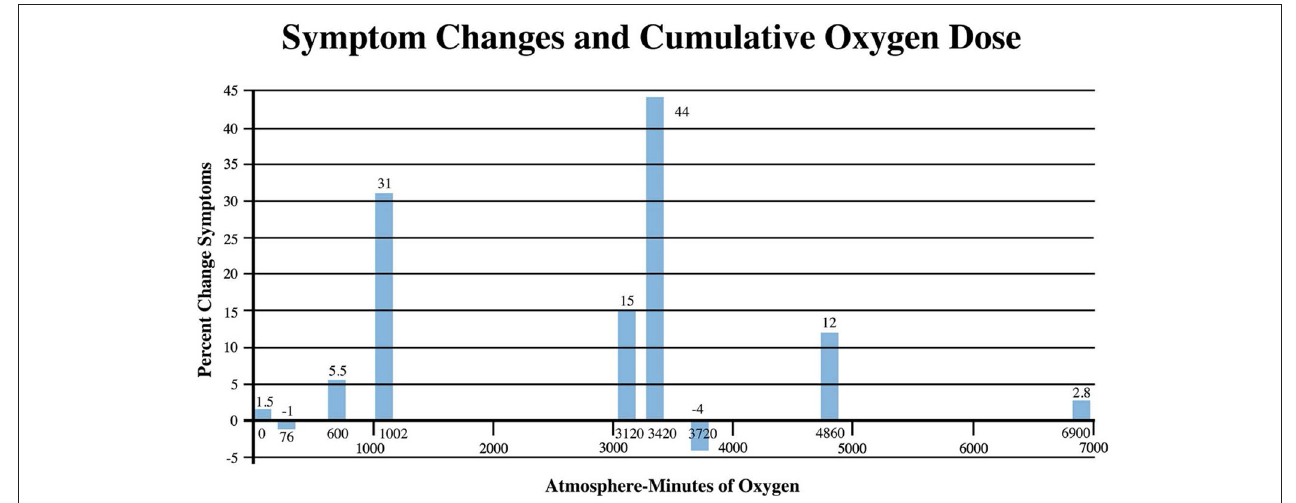
FIGURE 3 | Symptom Improvements from Table 2 vs. oxygen dose for HBOT mTBI PPCS studies. Symptom percent values represent the average percent improvement in symptoms for each oxygen dose in Table 2 , averaging the three different instrument (ImPACT, NSI, and RPQ) symptom outcomes.